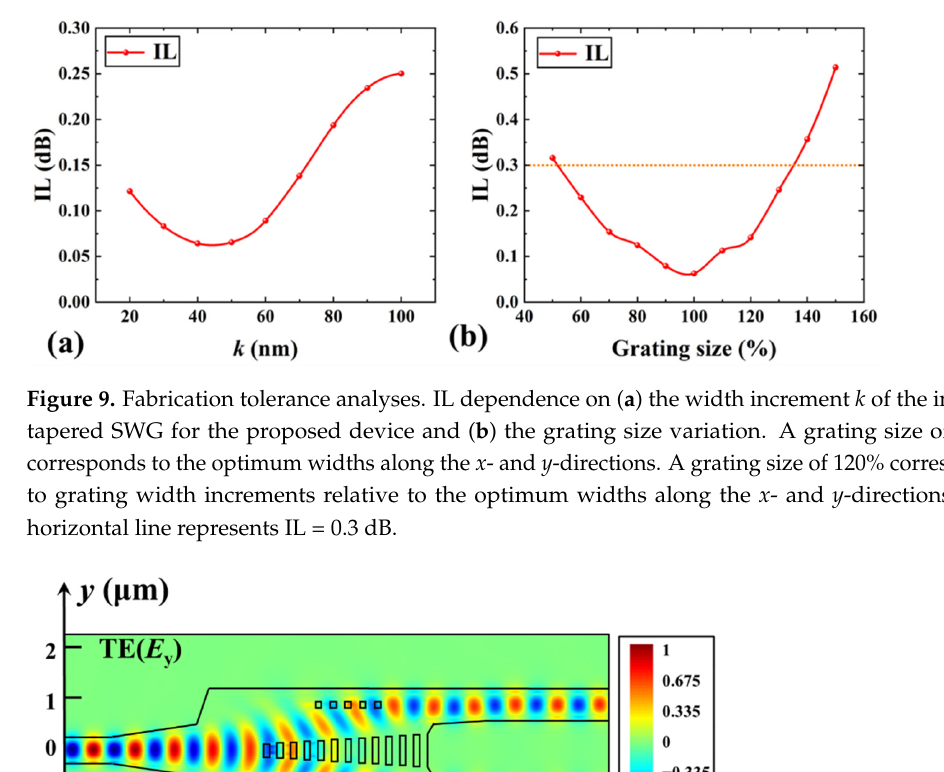
Figure 10. Electrical field evolution of input fundamental TE 0 mode (dominant component: E y ) along the propagation direction through the proposed device, where the MMI length was 3.2 μ m.